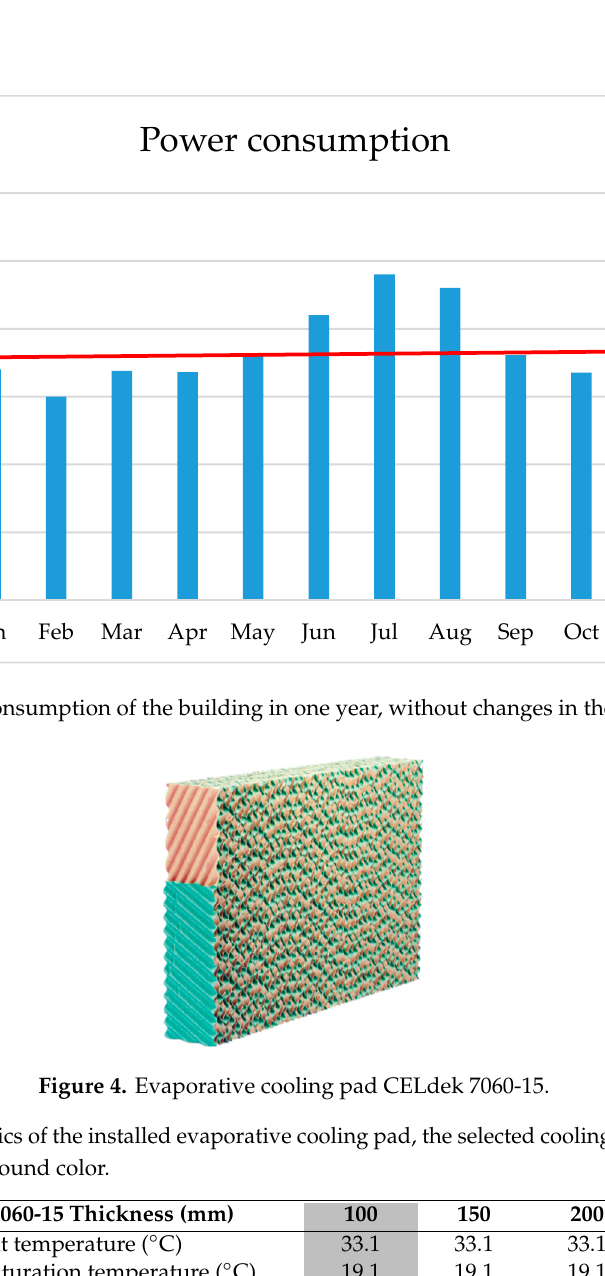
Figure 3. Power consumption of the building in one year, without changes in the cooling system.